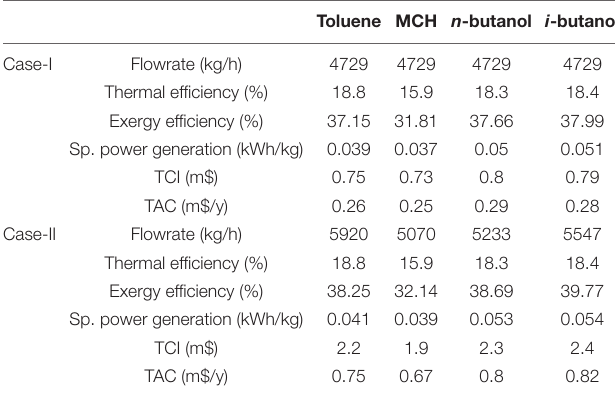
TABLE 7 | Organic Rankine cycle (ORC) performance comparison with same flowrate (case-I) and with different flowrate (case-II) of working fluids. Toluene MCH n -butanol i